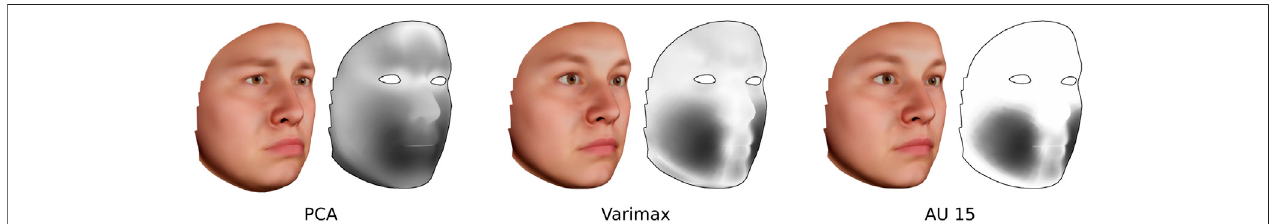
FIGURE 1 | Comparison of the surface deformation and deformation magnitude, intensity-coded from white (low) to black (high) , between a PC of a sad expression, the varimax-rotated component including depression of the lip corners, and the fi nal edited AU.